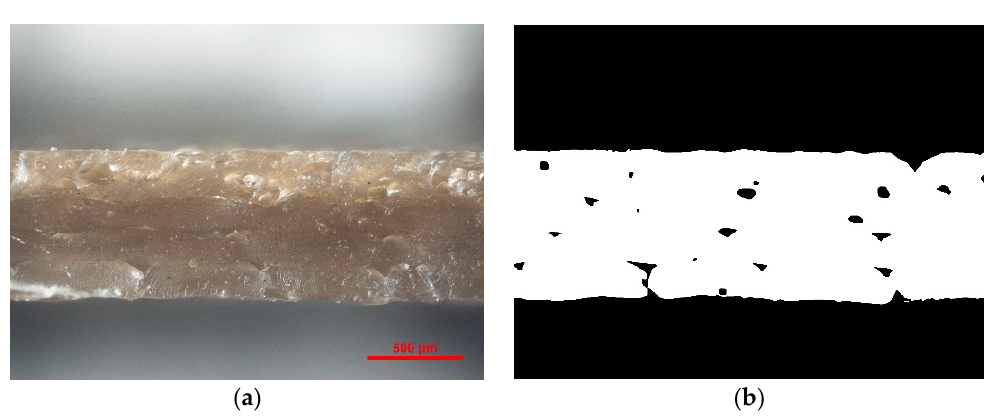
Figure 9. PC/3%B microstructure: ( a ) microscope image, ( b ) image from porosity calculation program.